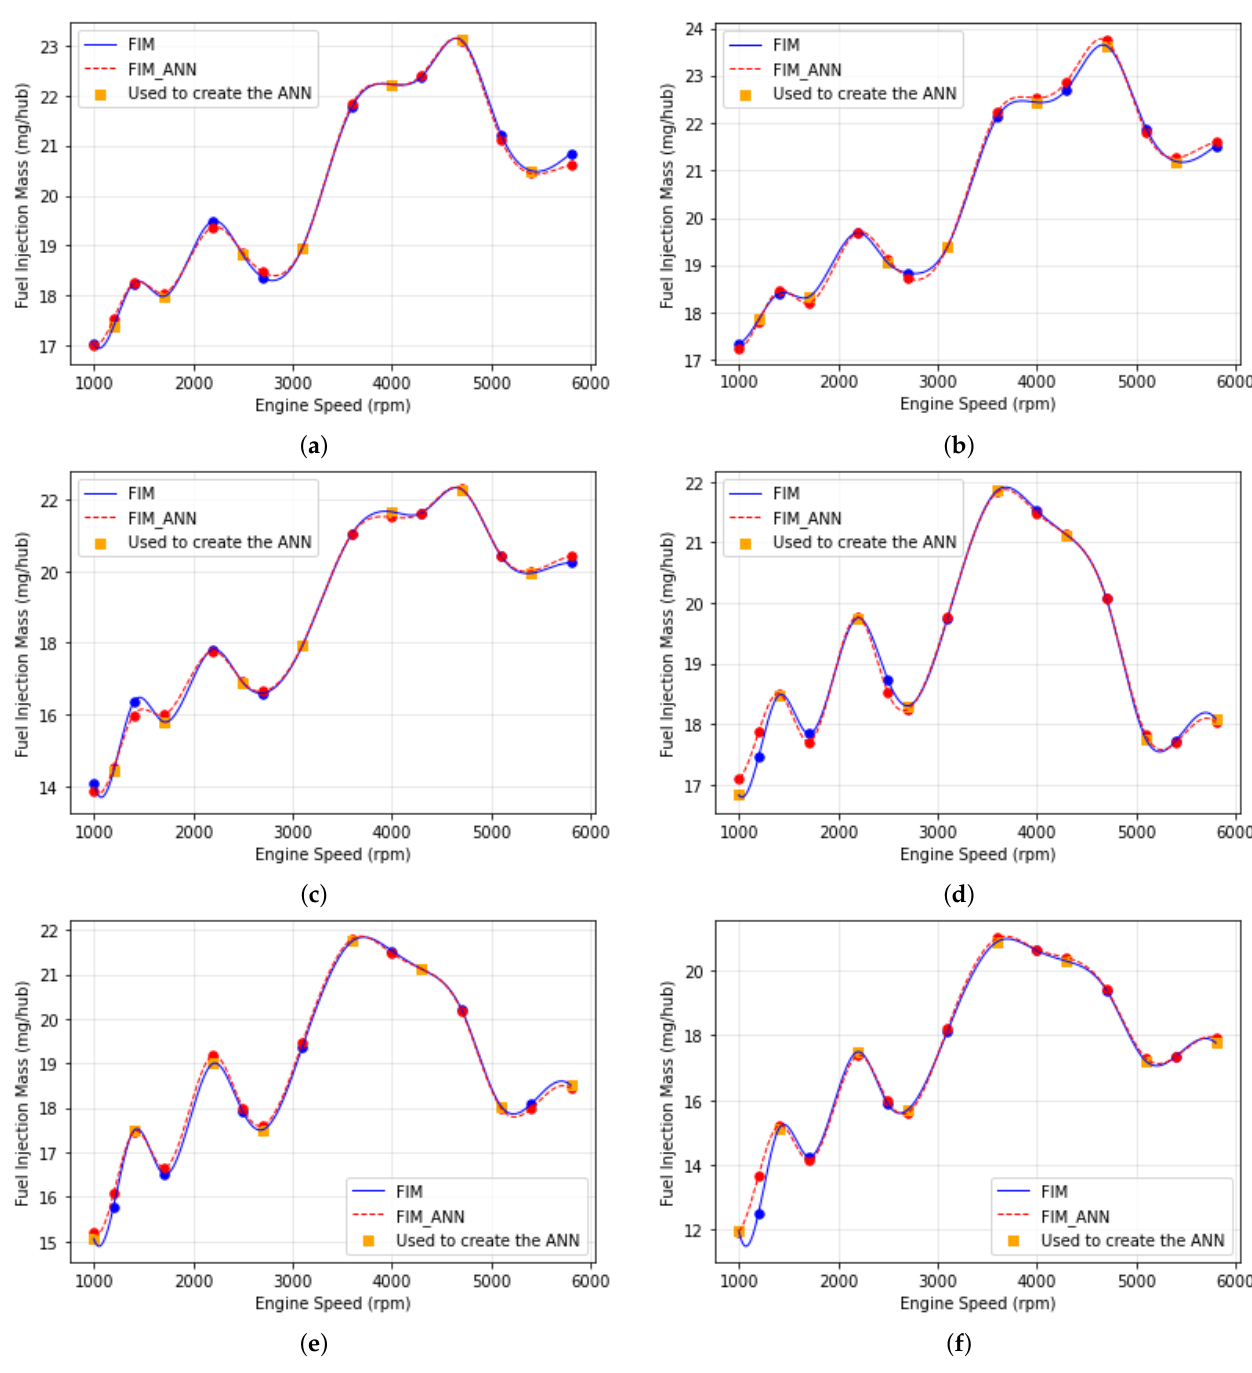
Figure 12. Fuel Injection Mass vs. Engine Speed in 540 mbar and ( a ) VVT_Exaust = 0/VVT_Intake = 10, ( b ) VVT_Exaust = 20/VVT_Intake = 10, ( c ) VVT_Exaust = 40/VVT_Intake = 10, ( d ) VVT_Exaust = 0/VVT_Intake = 40, ( e ) VVT_Exaust = 10/VVT_Intake = 40, ( f ) VVT_Exaust = 20/VVT_Intake =